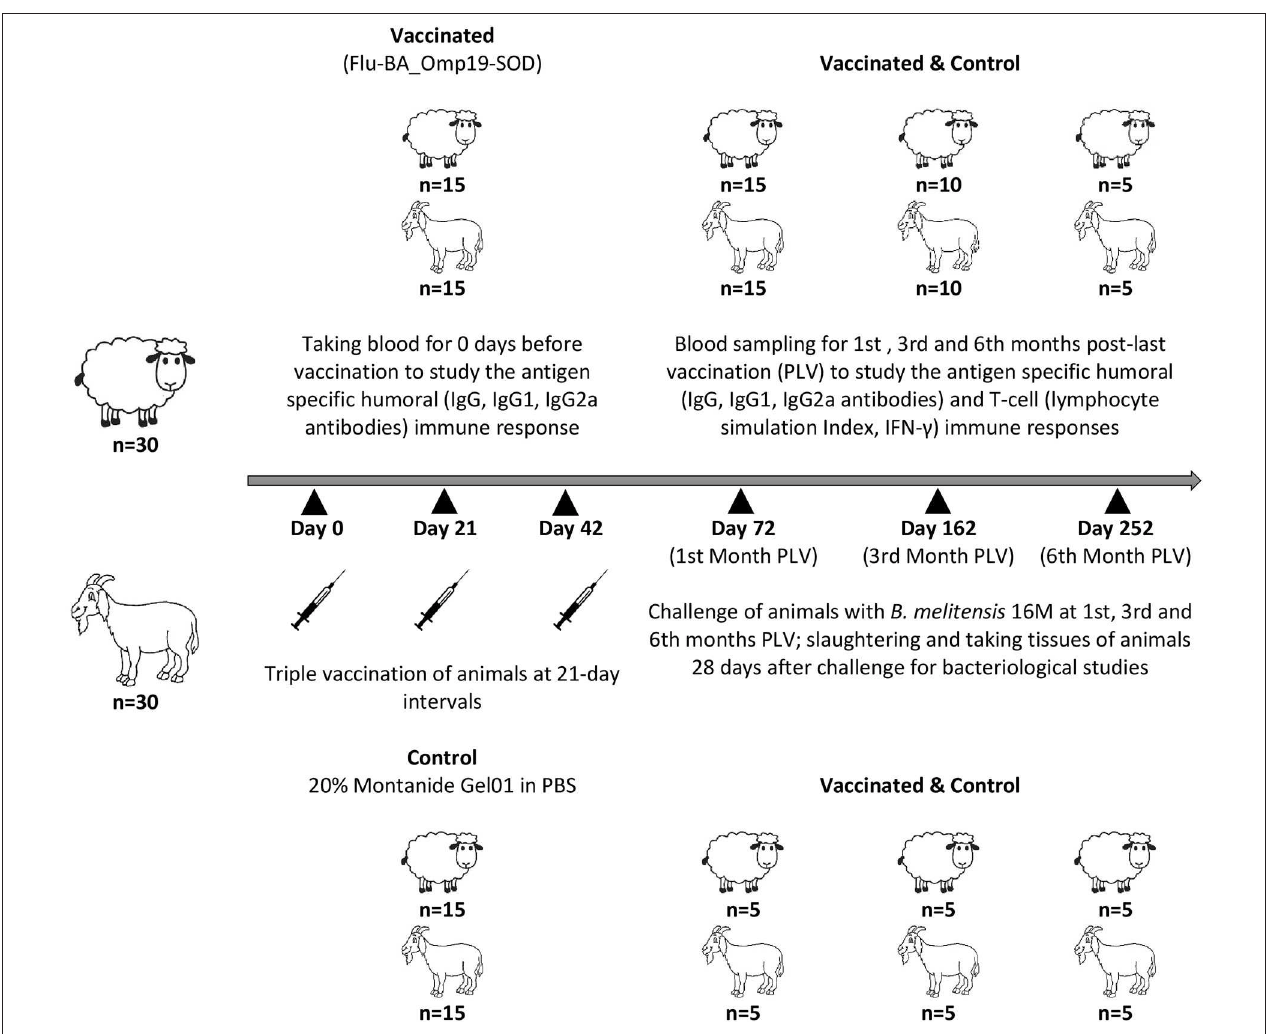
FIGURE 1 | Experimental